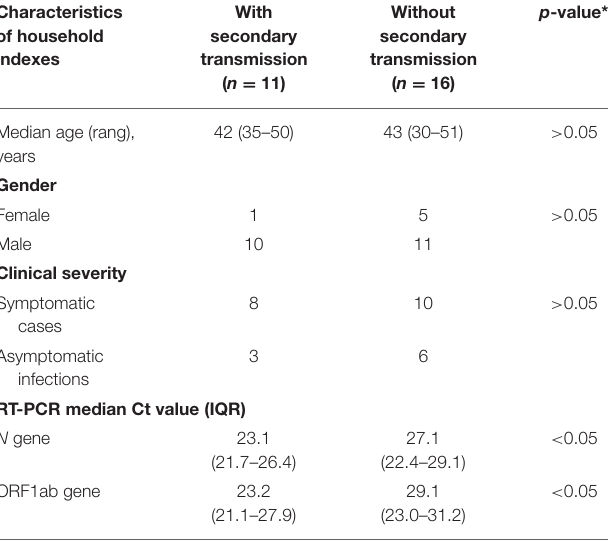
TABLE 3 | Characteristics of household indexes in the SARS-CoV-2 delta variant outbreak in Jingmen City, Hubei Province, China in August 2021. Characteristics of